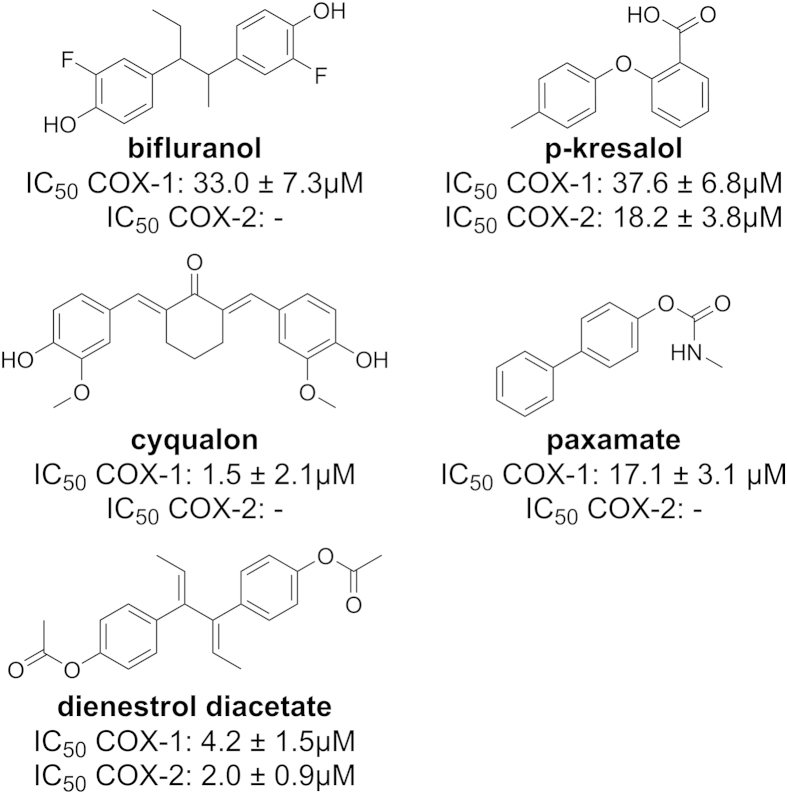
Structures and IC50 values of the active compounds.